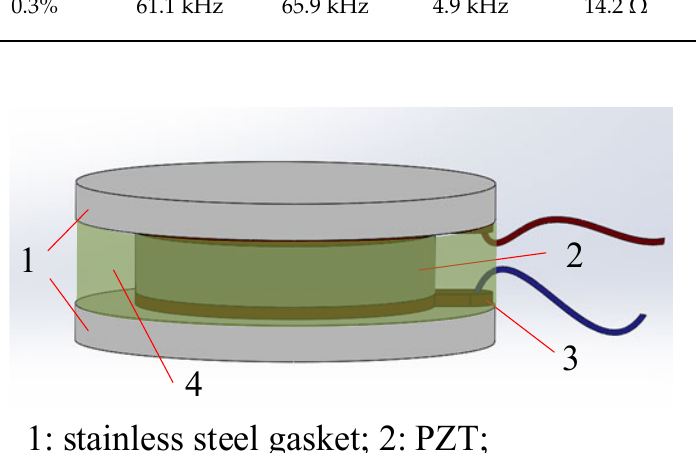
Figure 4. A prototype of piezoelectric sensing unit. 3. Design of Distributed WIM System Due to the vertical vibration of the vehicle itself, as well as the deformation, uneven- ness, or defects of the road surface, the vertical vibration of the measured vehicle is caused. In this case, the wheel load of the vehicle (the pressure of the vehicle tires on the road surface) is dynamically changing with a certain periodicity. Obviously, the error between the dynamic wheel load and the vehicle weight is closely related to the vibration charac- teristics of the running vehicle. At present, most of the sensors arranged in the WIM sys- tem only install strip sensors in a narrow range of the vehicle’s traveling direction. The time for the tires of the moving vehicle passing above the sensor is only about 0.01–0.1 s. The dynamic wheel load throughout the cycle of the change process cannot be detected. Furthermore, the results in the weighing system have to be calibrated on site. To make up for this shortcoming, we need to arrange multiple WIM sensors in the driving direction of the vehicle, but the existing WIM sensors are difficult to realize without breaking the in- tegrity of the outer road surface. However, this arrangement can be conveniently imple- mented using the previously proposed self-powered wireless sensors for WIM. These kinds of sensors do not need to be slotted and wired under the pavement surface because of the self-powered energy and wireless signal transmission. Hence, it can be designed as spatially independent distributed sensors, arranged in a certain form on the lane (Figure 5). Through layout optimization, the best distribution form that meets the actual require- ments can be obtained. Then, measuring the change of dynamic wheel load in the whole cycle would provide more reliable data for the calculation of static wheel load (vehicle weight) and more accurate identification of the vehicle wheelbase, axle number, and travel speed.